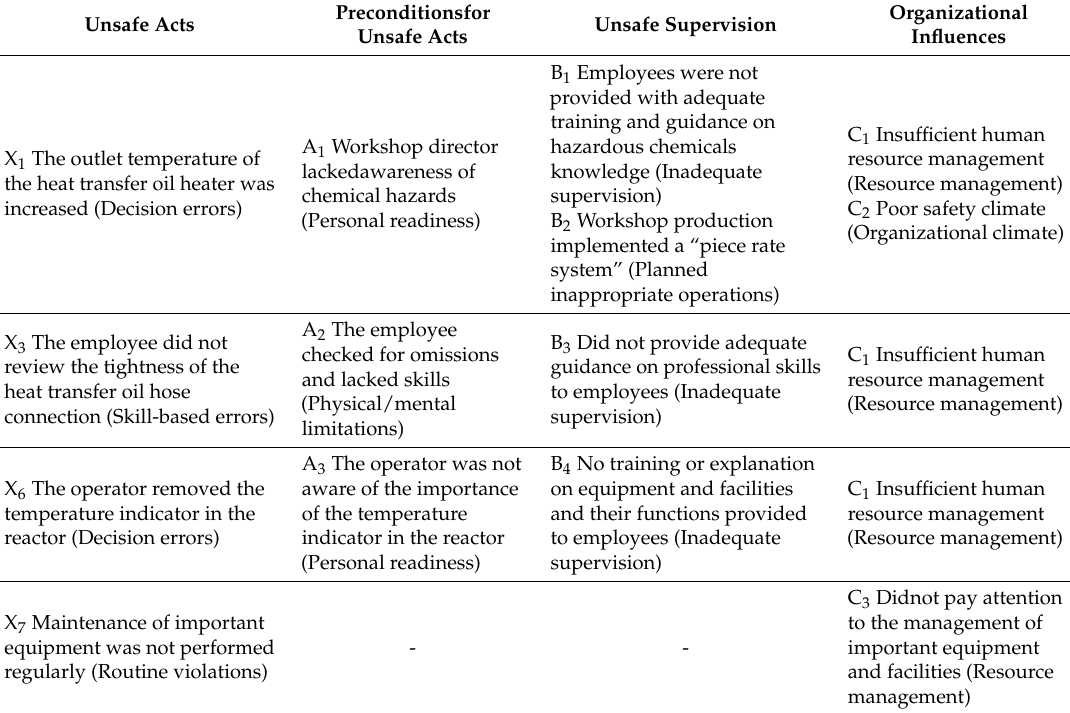
Table 3. Human error analysis using